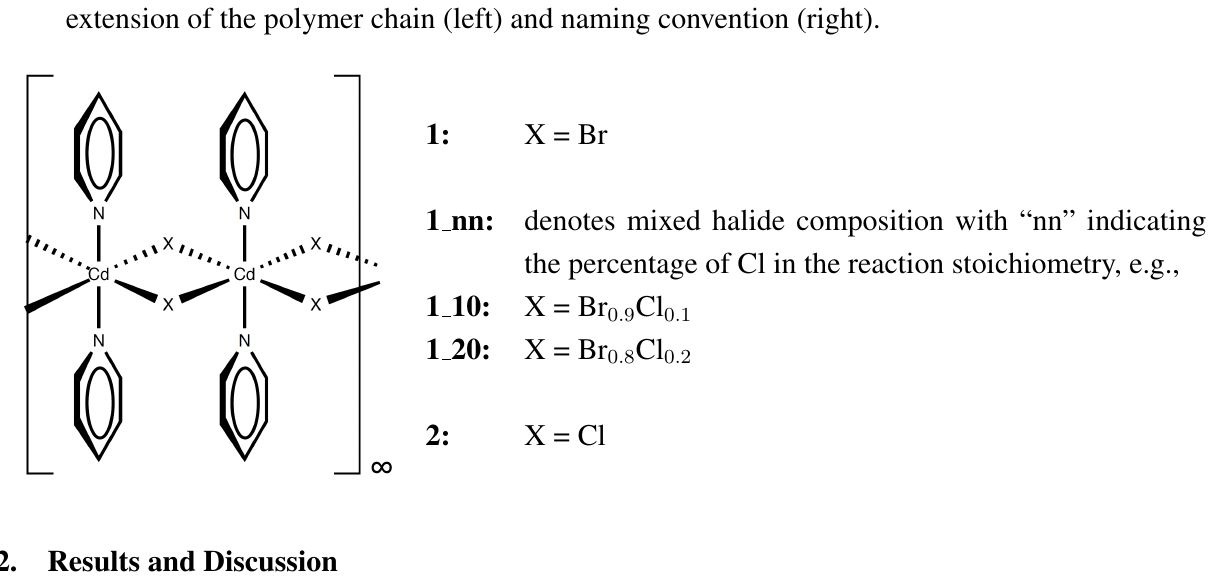
} 1 ] showing one-dimensional ( µ -Cl) py 2 − 2 x 2 x 2 ∞